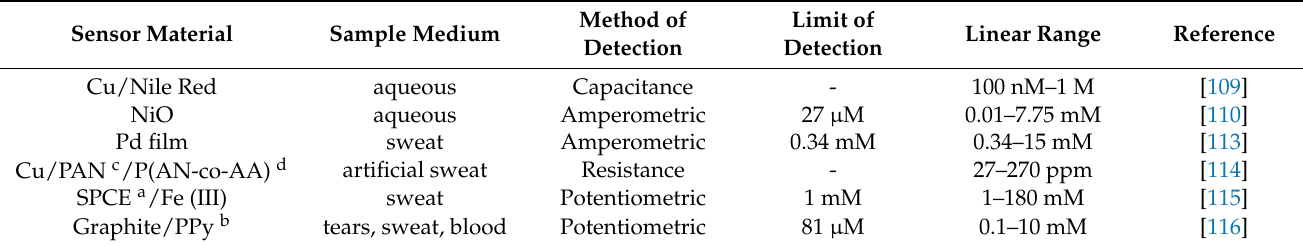
Table 3. Summary of non-enzymatic sensor platforms for the detection of lactate, highlighting the materials used, method of detection, biological medium, linear range, and limit of